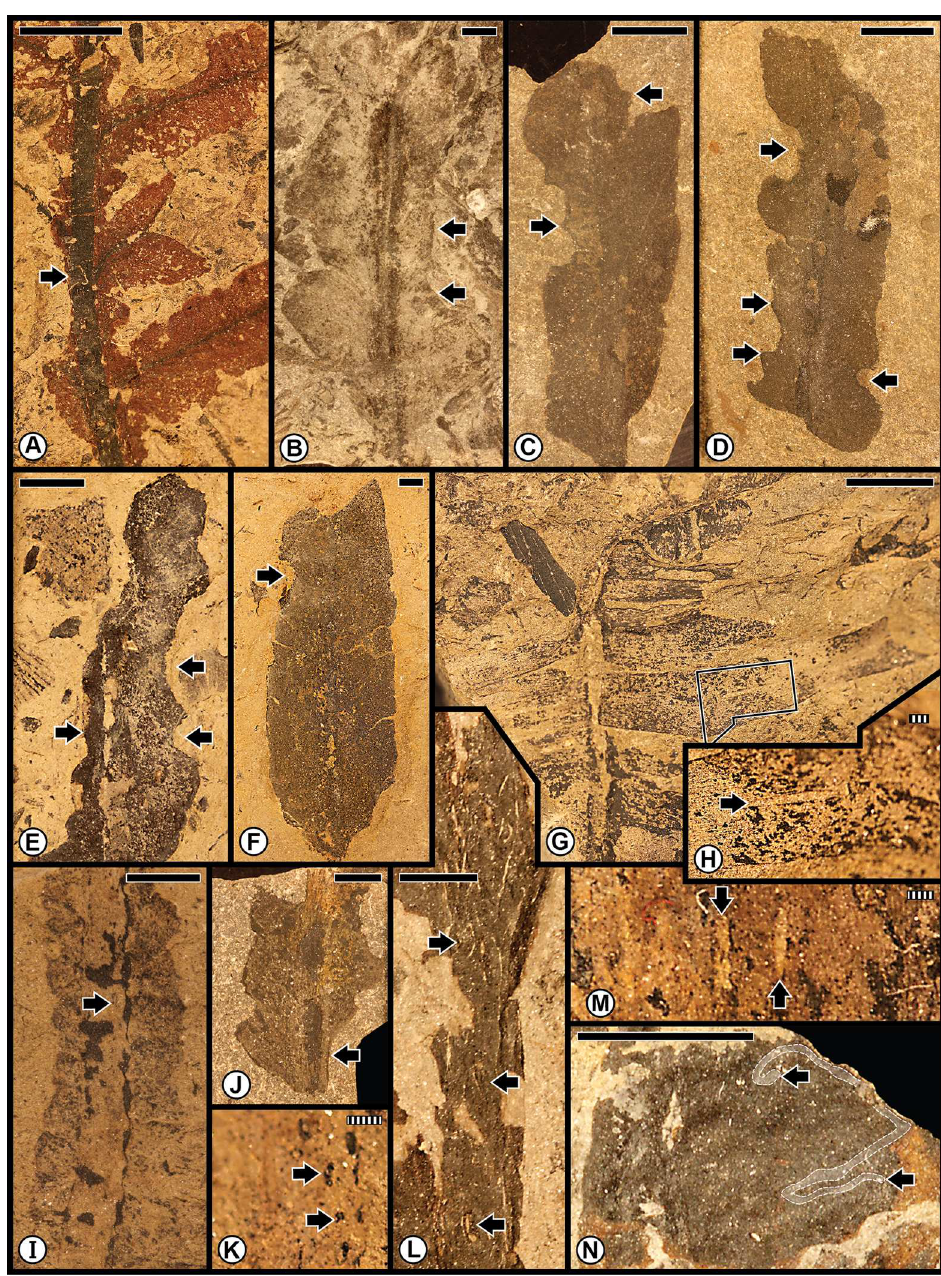
Fig 7. Plant–insect interactions from the Middle Triassic (Anisian) Furkelpass and related floras, of the Richthofen Formation near Olang/Valdaora in the northern Dolomites. A : Extensive margin feeding (DT12, DT14) of pinnularfoliage on the pteridosperm Scytophyllum bergeri , indicatedby black arrows. Specimen PAL-492. B : The pinnularmargin of Scytophyllum bergeri is altered along its blade by margin feeding(DT12), indicatedby black arrows. Specimen PAL-523. C : Another pinnuleof Scytophyllum bergeri displaying margin feeding damage(DT12, DT143). SpecimenPAL-466. D : Pinnuleof Scytophyllum bergeri , exhibitingsingle (DT12) and multiple (DT143) examples of margin feeding. Specimen PAL-513. E : A Scytophyllum bergeri pinnuledisplaying single and continuousmargin feeding(DT12, DT143). Specimen PAL-481. F : Margin feeding (DT12) on the pteridosperm Scytophyllum bergeri . Specimen PAL-473. G : A frond portion of Scytophyllumbergeri with several pinnules,one of which displays an example of slot feeding (DT08). Specimen PAL-469. H : Enlargement of pinnulein the polygonat the lower-left of (G), showingslot feeding. I : A specimenof showinga minisculeexample of oviposition (DT76) on woody tissue, indicatedby a black arrow. Specimen PAL-468. J : A pinnularfragment of Scytophyllum bergeri with extensive